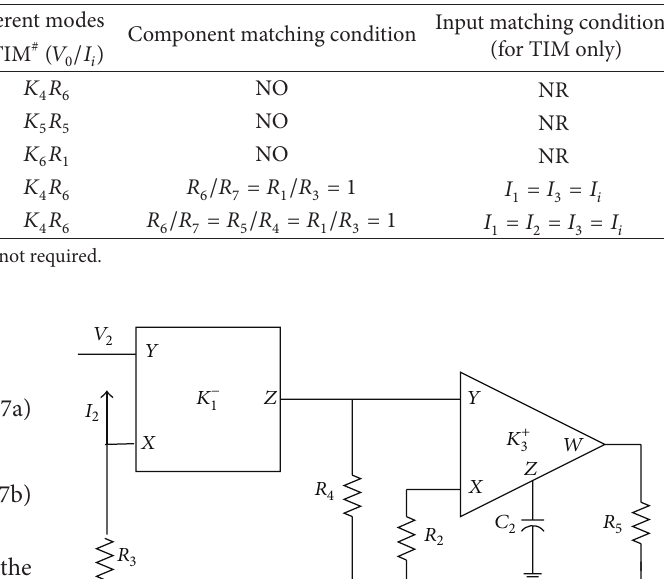
Table 1: Codeword combination and realized filter functions.